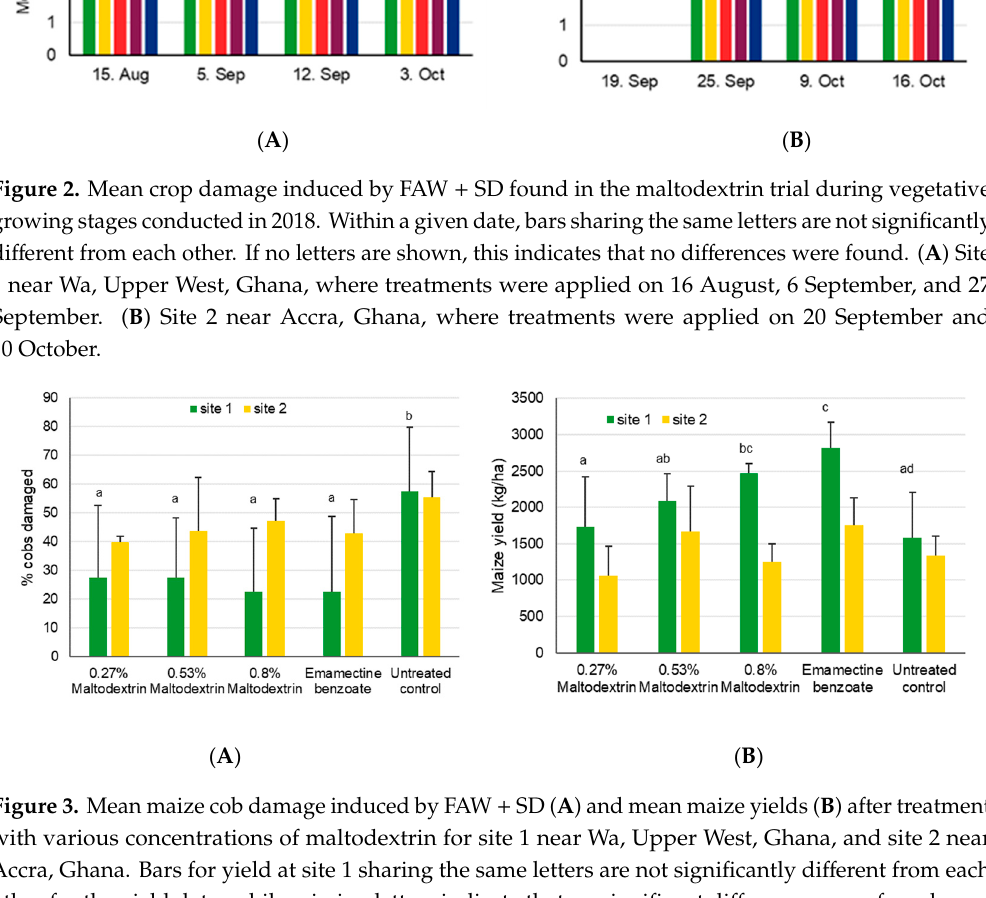
Figure 2. Mean crop damage induced by FAW + SD found in the maltodextrin trial during vegetative growing stages conducted in 2018. Within a given date, bars sharing the same letters are not significantly different from each other. If no letters are shown, this indicates that no differences were found. ( A ) Site 1 near Wa, Upper West, Ghana, where treatments were applied on 16 August, 6 September, and 27 September. ( B ) Site 2 near Accra, Ghana, where treatments were applied on 20 September and 10 October.